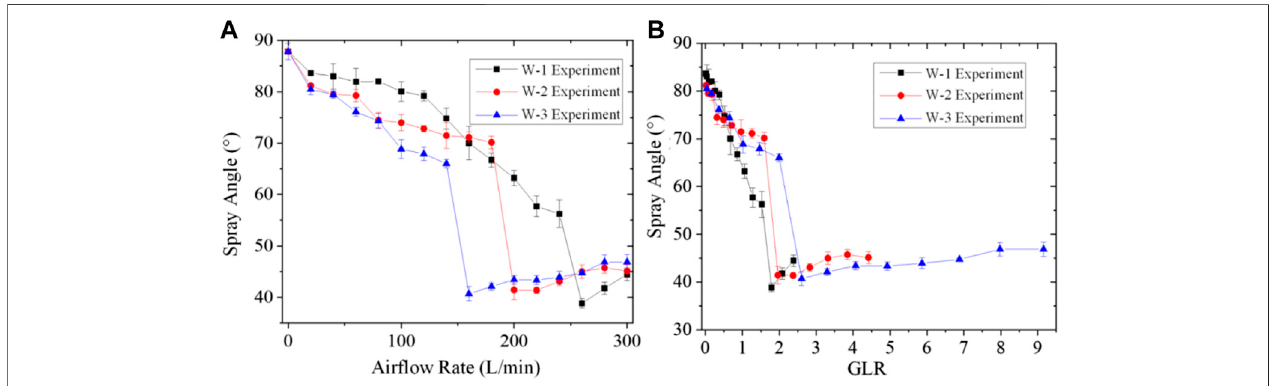
FIGURE 4 | Impacts of the (A) gaseous fl ow rate and (B) gas-to-liquid momentum ratio on the spray cone angle for different coaxial injectors.